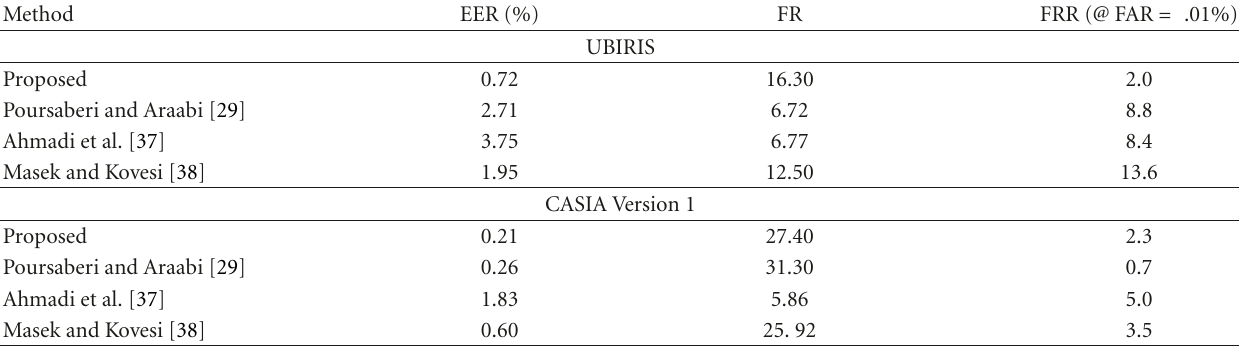
Table 1: Comparison between the error rates obtained from the proposed method and the other state-of-the-art algorithms for the UBIRIS and CASIA Version1